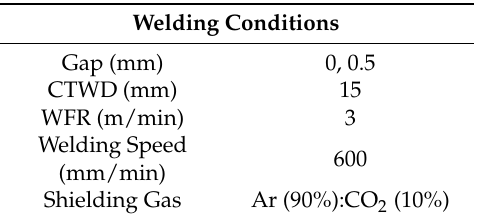
Table 2. Welding experimental conditions.